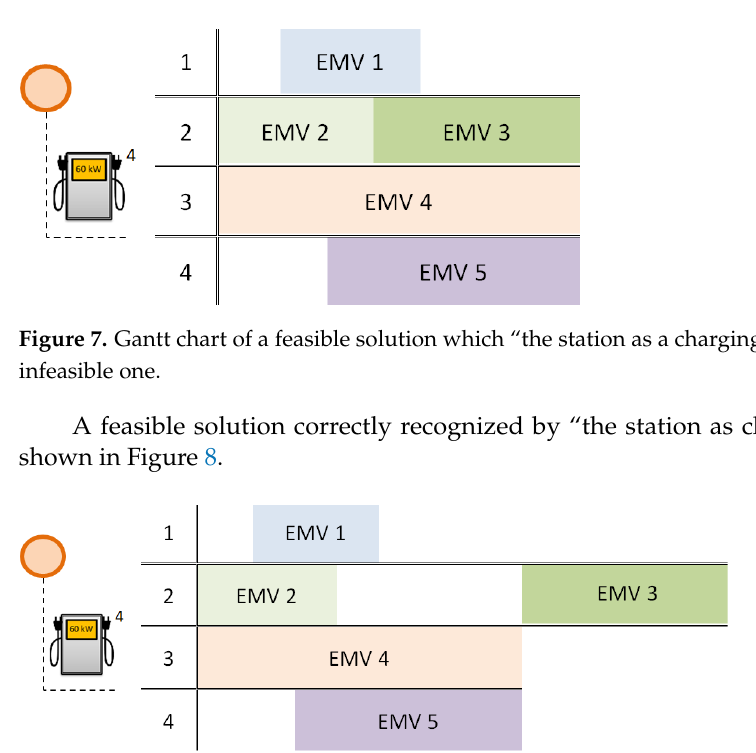
Figure 8. Gantt chart of a feasible solution for “the station as a charging point